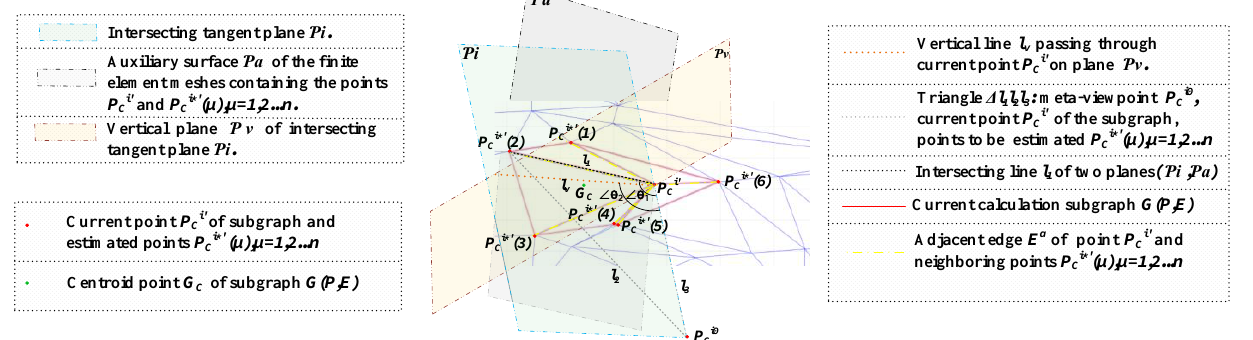
Figure 2. MPCS and its annotations.